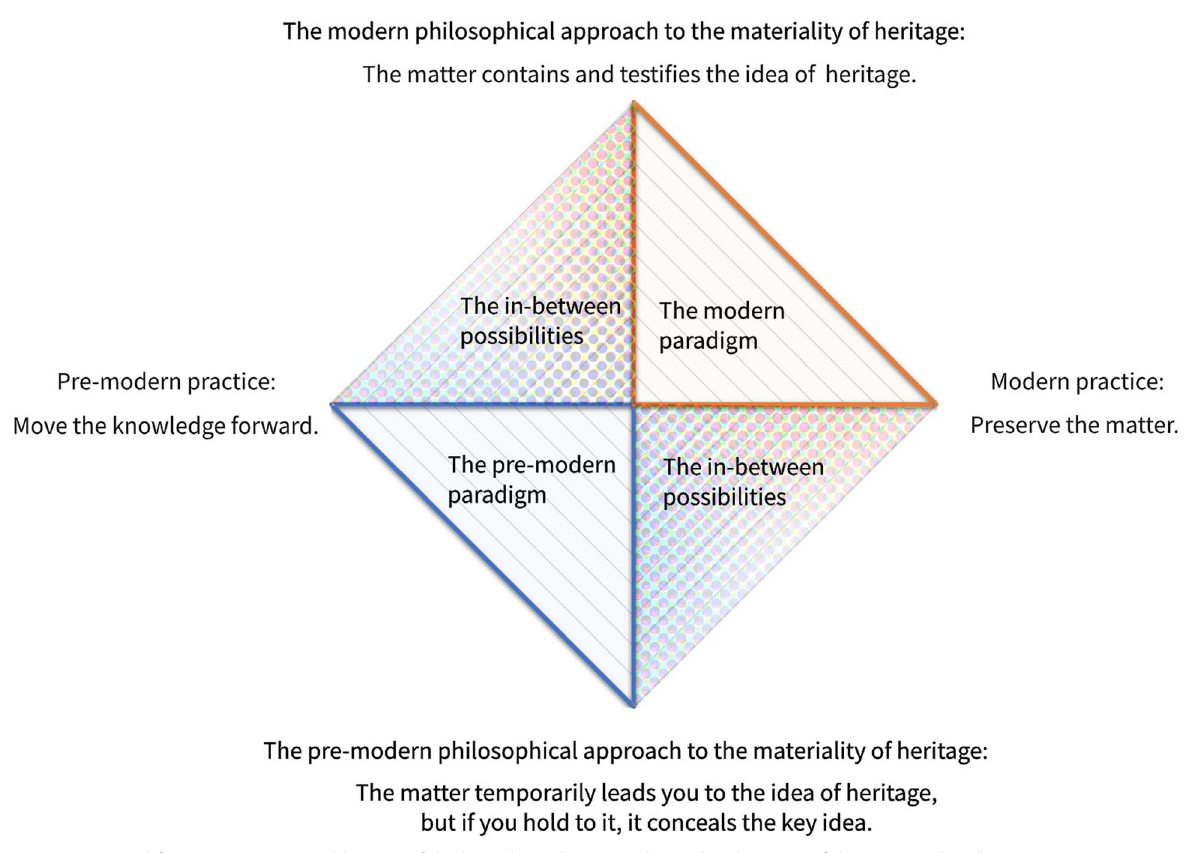
Fig. 7 A proposal for investigating possible ways of thinking about the materiality and authenticity of the Iranian urban heritage (Source: the